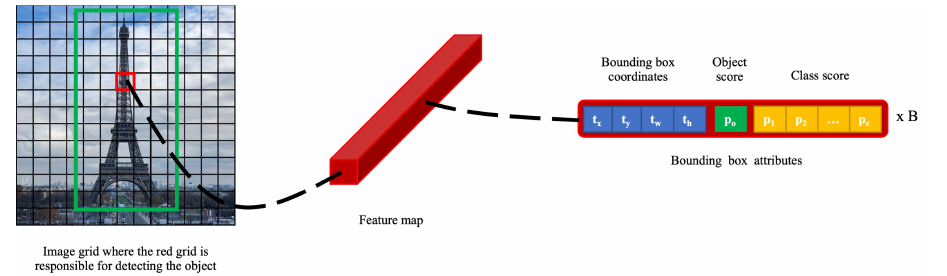
Figure 12. YOLOv3 detection procedure at tensor